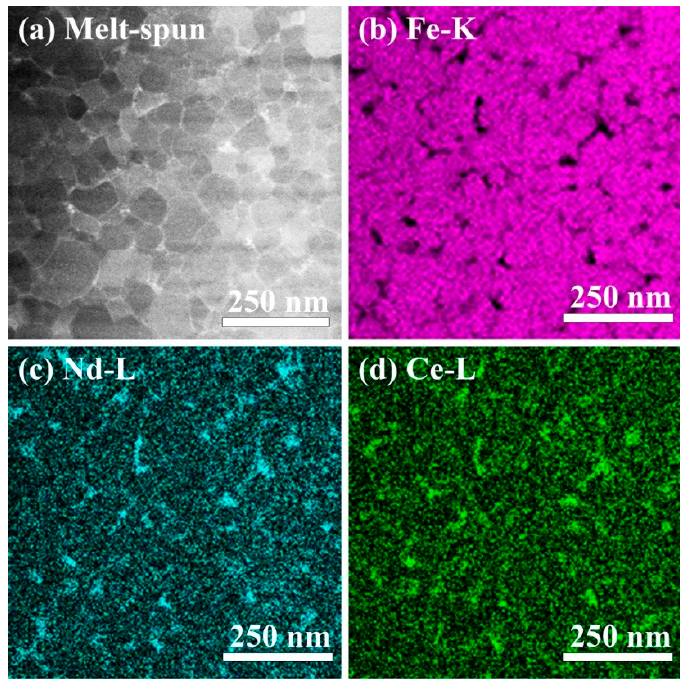
Figure 3. ( a ) High angle annular dark field (HAADF) image of the region close to the free surface of melt-spun (Nd 0.8 Ce 0.2 ) 2.4 Fe 12 Co 2 B ribbon, and scanning transmission electron microscope with energy-dispersive X-ray spectroscopy (STEM-EDS) elemental mapping images for ( b ) Fe-K, ( c )